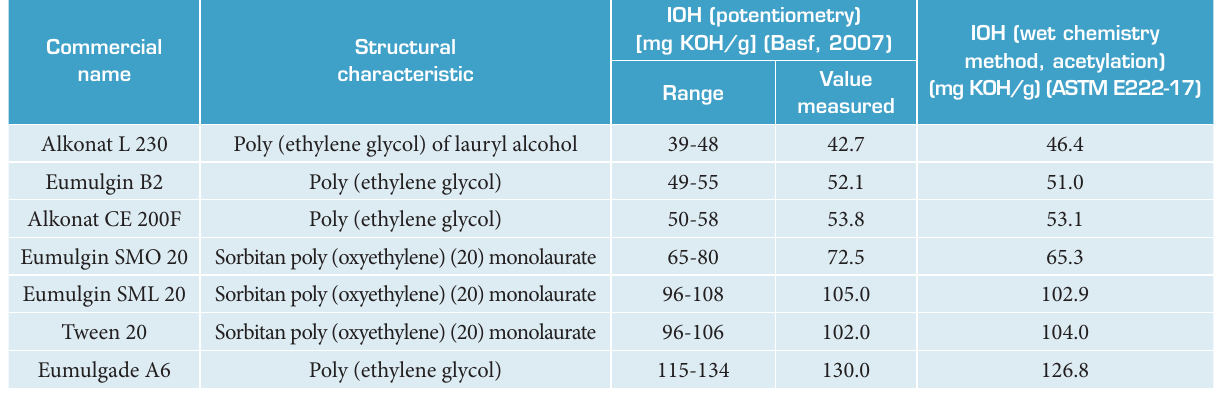
Table 1. Composition and structural characteristics of surfactants and IOH values.